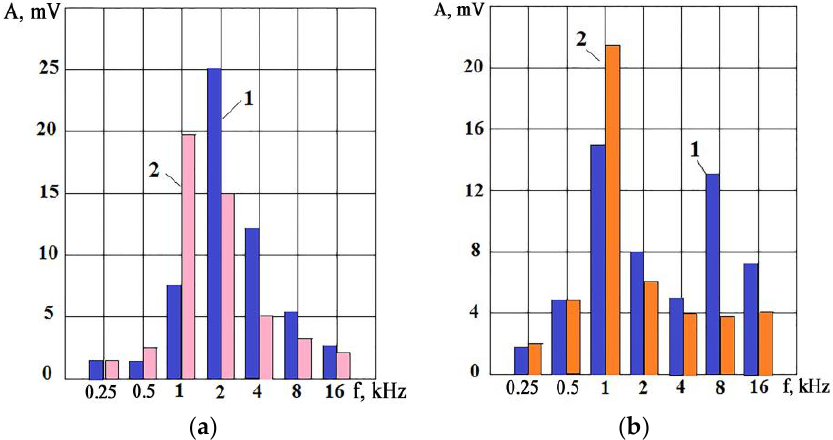
Figure 1. Octave spectra of the VA signal during grinding of steel 45 (ASTM1045) on a CNC circular grinding machine: ( a ) internal in-feed grinding (rotation velocity of the circle = 12,000 rpm, of the spindle = 150 rpm, t = 0.1 mm, circle diameter = 50 mm); ( b ) external longitudinal grinding (rotation velocity of the circle = 1200 rpm, of the spindle = 100 rpm, t = 0.2 mm, circle diameter = 750 mm). ( 1 ) — circle after editing; ( 2 ) — worn circle.